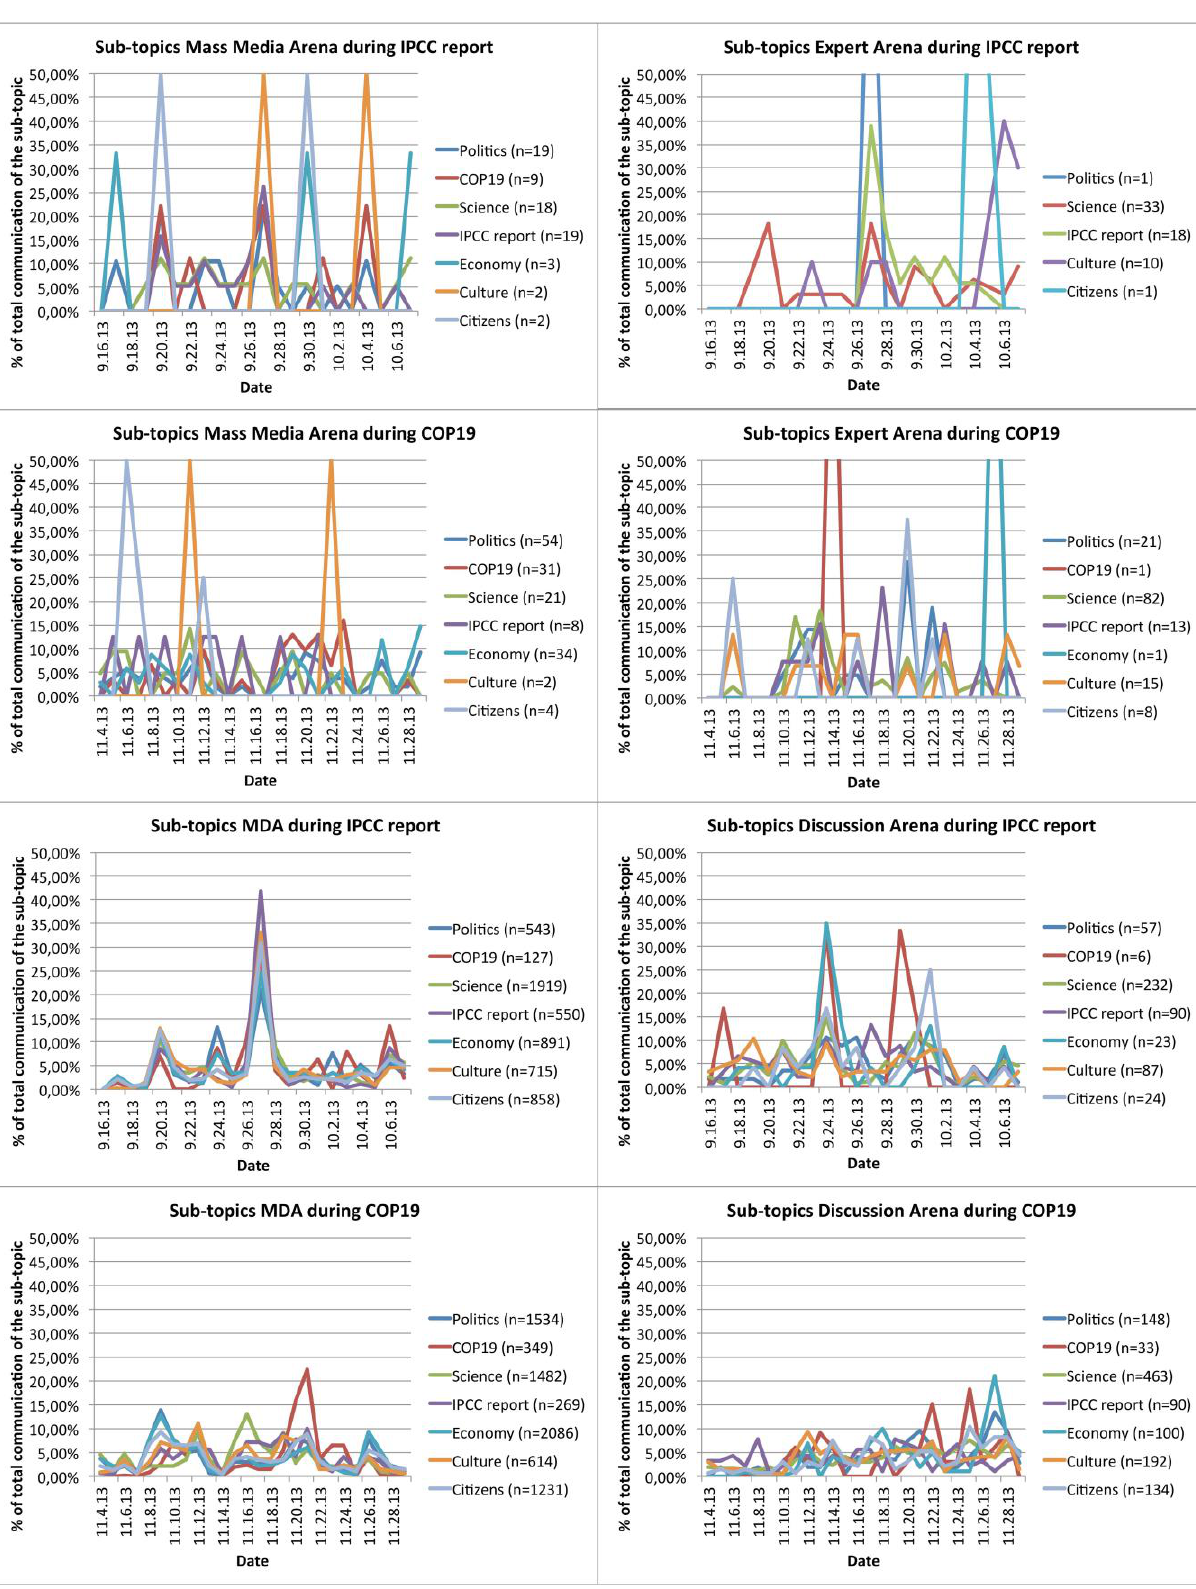
Figure 7. Overview: Dynamics of arena-specific sub-topics during the release of the IPCC report 2013 and COP19. Note: Different scales used in support of a better